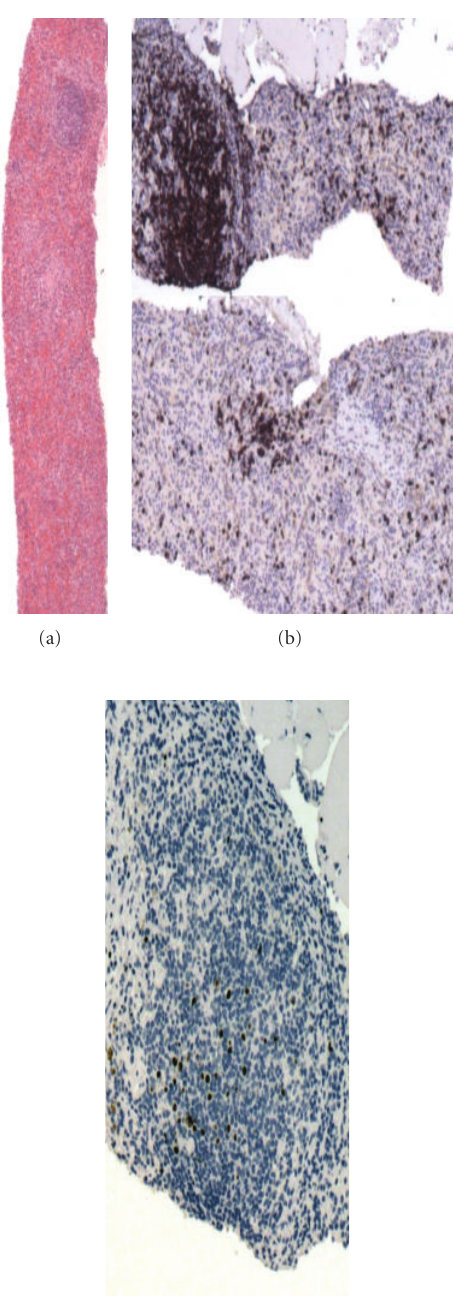
Figure 3: Composite picture of splenic biopsy showing H & E picture on (a), CD79a in the top and bottom (b) and HHV-8 staining cells on (c).